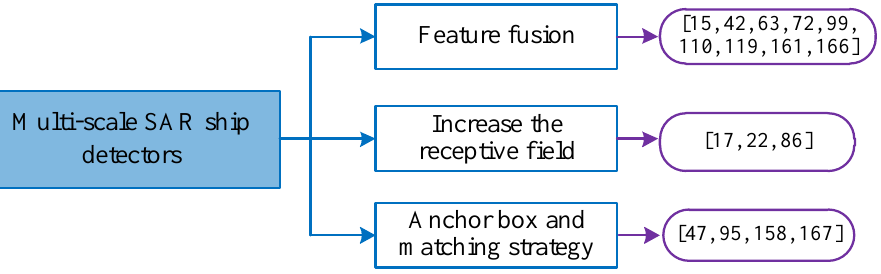
Figure 12. The multi-scale SAR ship detectors.